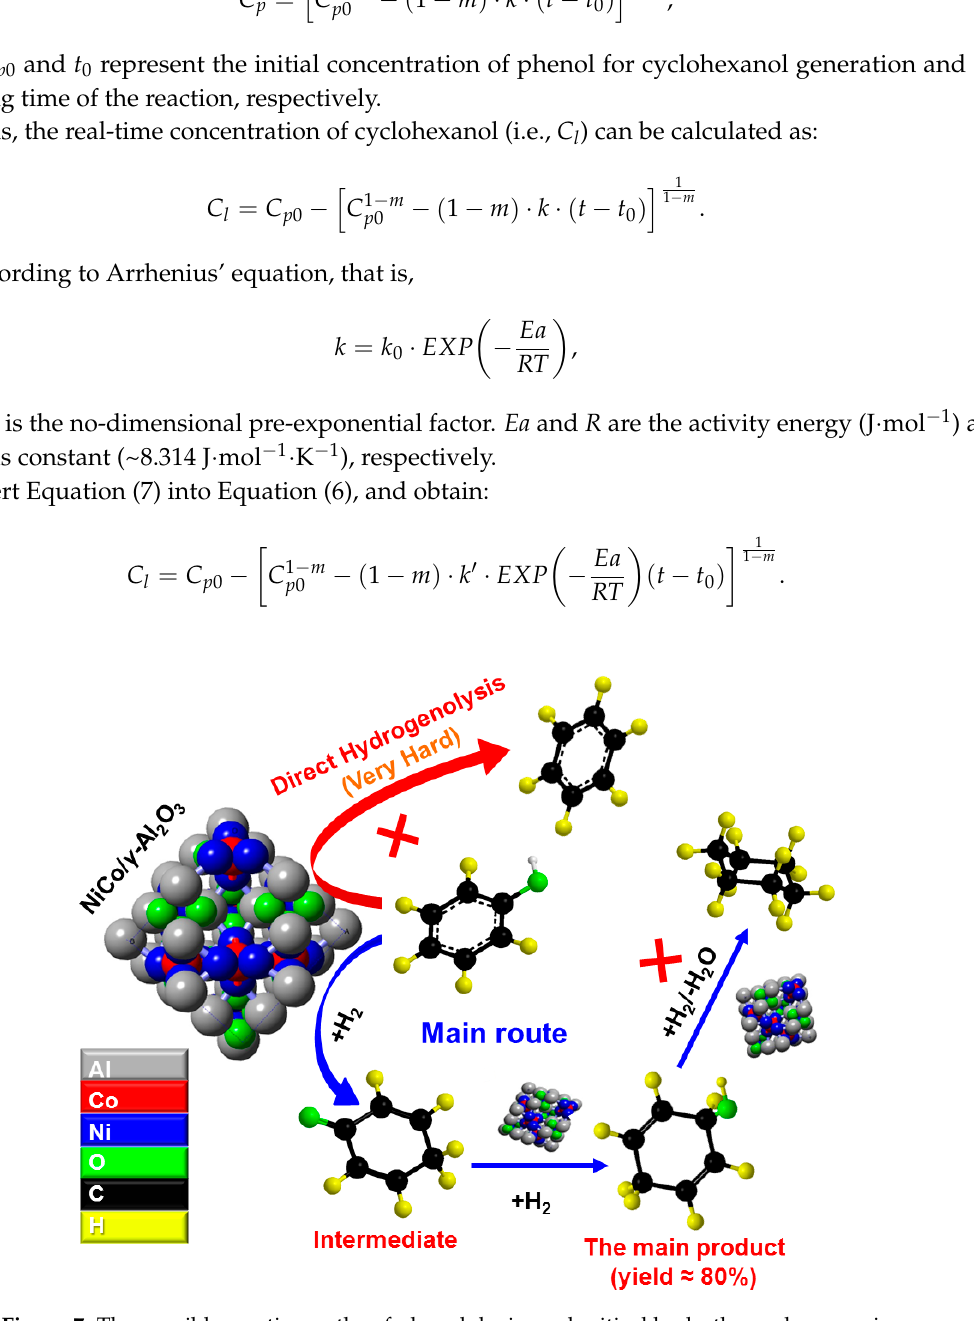
Table 2. The values of the parameters from curve fitting.